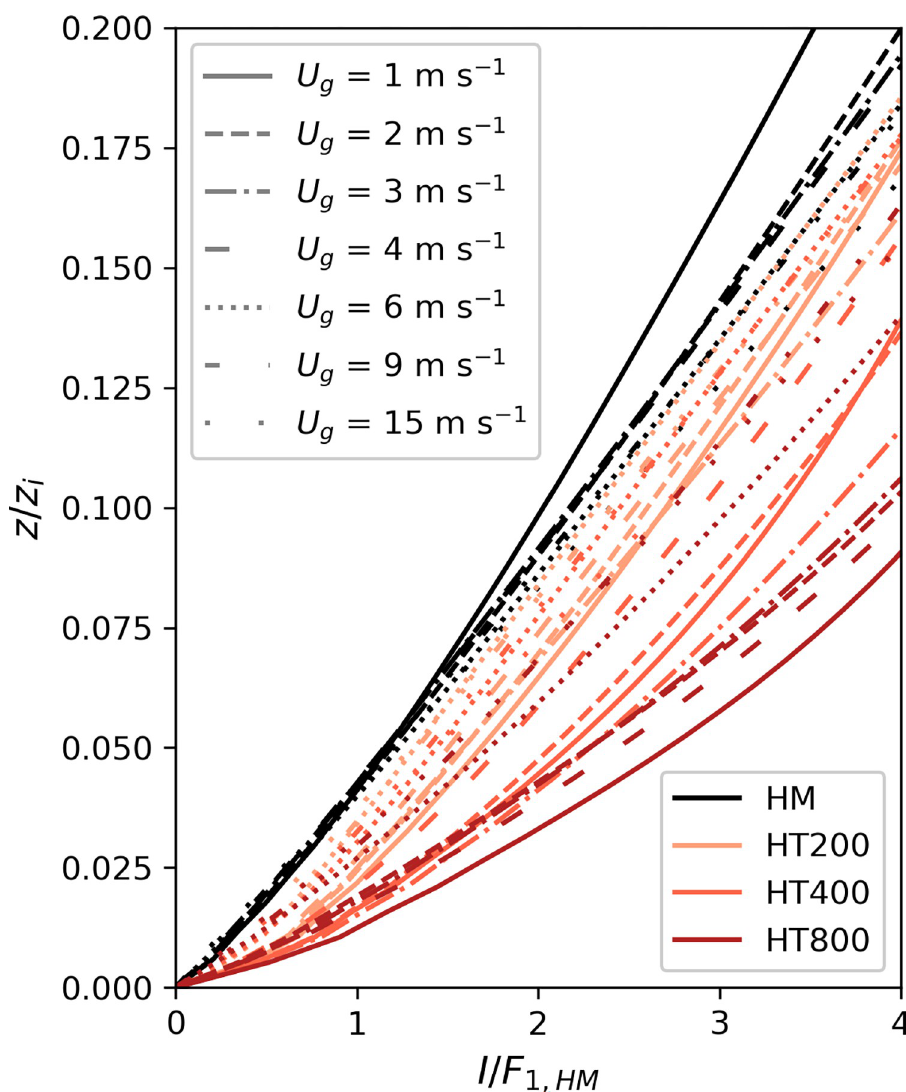
Fig 3. Vertical profiles of the imbalance all normalized with the same scaling function F 1,HM (Eq 11, Table